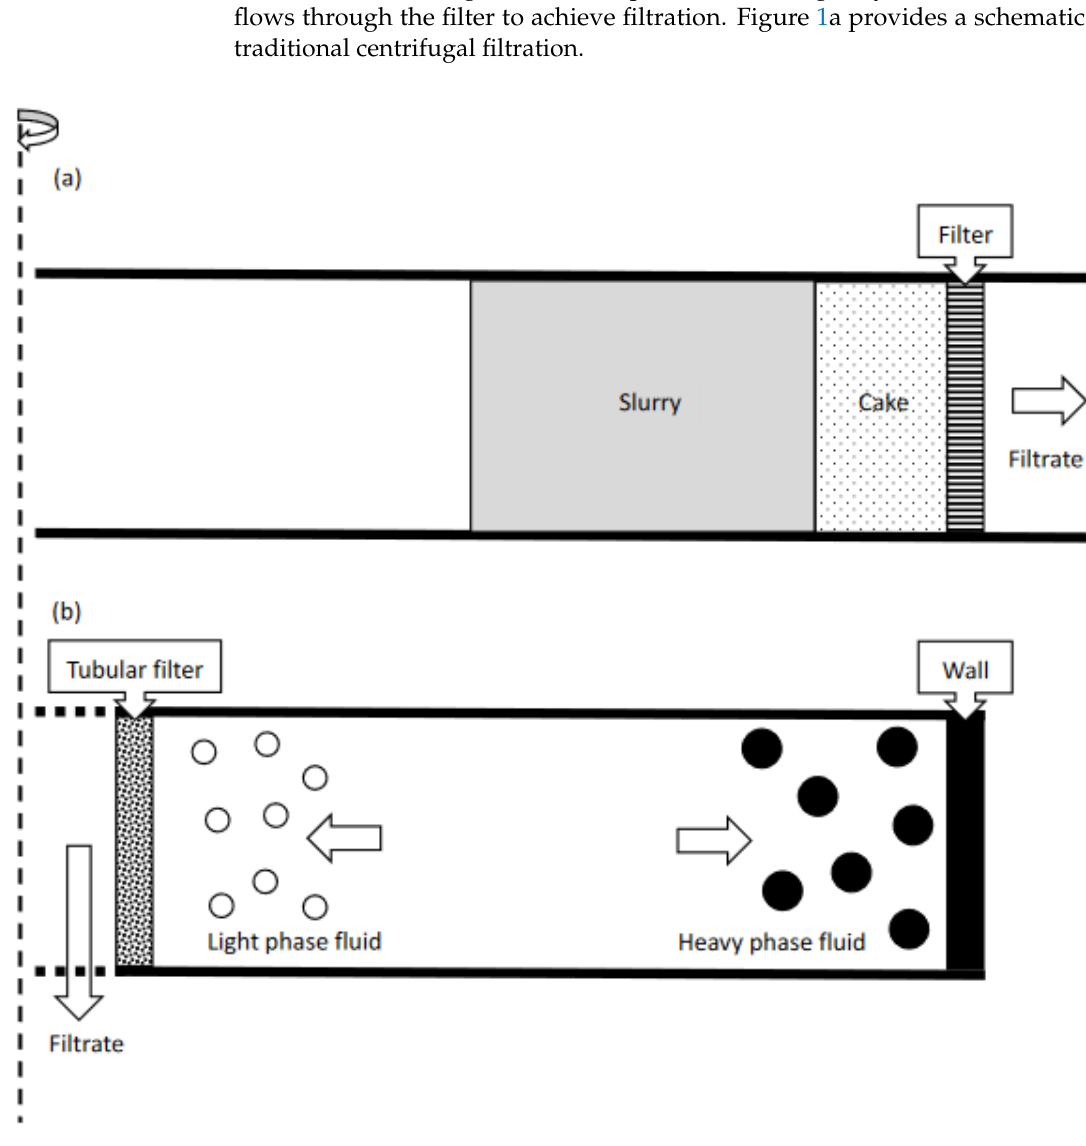
Figure 1. Schematic diagrams of ( a ) traditional centrifugal filtration and ( b ) the novel centrifugal filtration device proposed in this study.